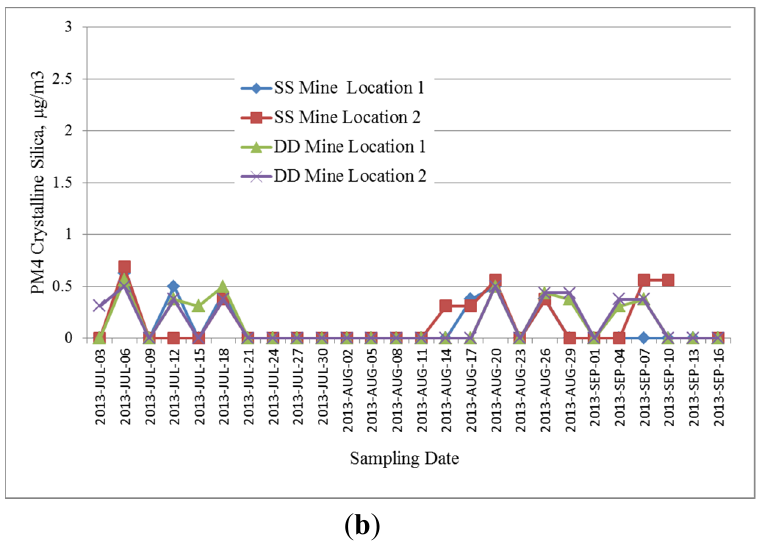
Figure 11. Variations in PM4 Crystalline Silica Concentration at the ( a ) Chippewa Falls Plant and the DS Mine, July 3, 2013 to September 16, 2013; ( b ) the SS and DD Mines, July 3, 2013 to September 16, 2013.